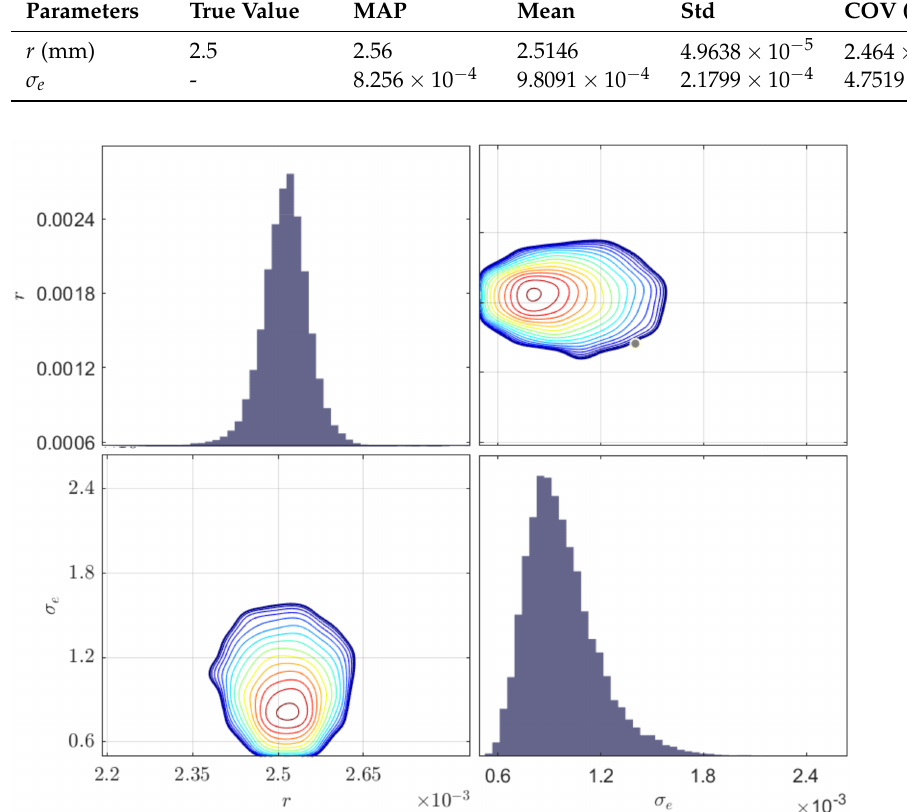
Figure 10. Posterior distribution of different parameters and contours of two − dimensional simulation densities inferred from full finite element model; the diagonal plots indicate the marginal distributions of the inferred